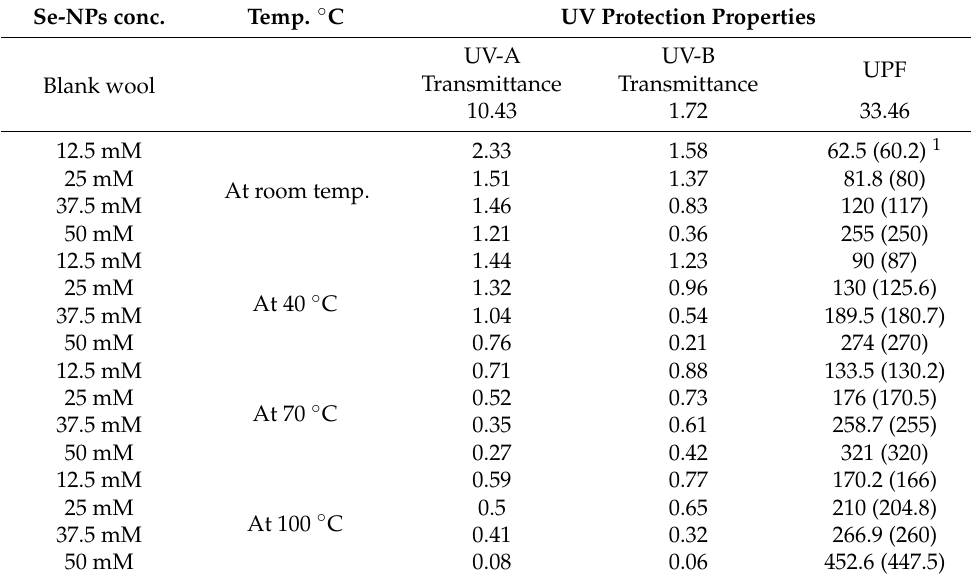
Table 2. UV protection properties of Se-NPs dyed wool fabrics at different temperatures. Se-NPs